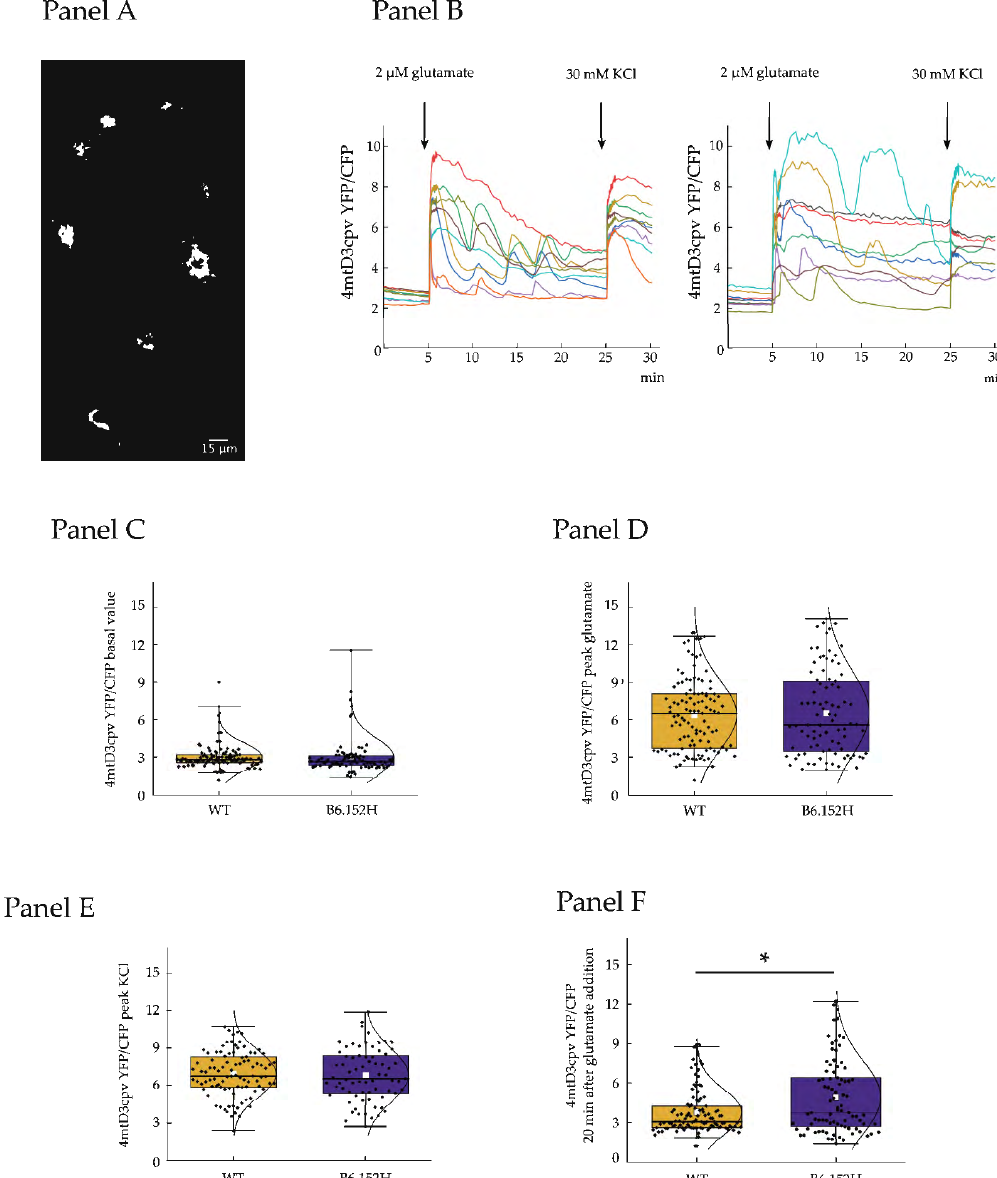
Figure 8. Mitochondrial Ca 2+ transients in hippocampal primary cultures induced by glutamate. Panel ( A ), representative image of 14 div hippocampal neurons expressing mitochondria-targeted cameleon probe 4mtD3cpv. Panel ( B ), representative traces of mitochondrial Ca 2+ uptake in hippocampal neurons expressing 4mtD3cpv, left WT; right B6.152H cells. Where indicated the cells were challenged with 2 µ M glutamate and 30 mM KCl addition. Panels ( C – E ), quantifications of 4mtD3cpv ratio fluorescence for, respectively: C basal values (WT n = 111 cells, median = 2.83; B6.152H n = 89 cells, median = 2.66, Mann–Whitney probability test, exact prob. = 0.063: at the 0.05 level, the two distributions are not significantly different); ( D ), peak glutamate (WT n = 111 cells, median = 6.5; B6.152H n = 89 cells, median = 5.6, Mann–Whitney probability test, exact prob. = 0.858: at the 0.05 level, the two distributions are not significantly different); ( E ) peak KCl (WT n = 95 cells, median = 6.76; B6.152H n = 71 cells, median = 6.54, Mann–Whitney probability test, exact prob. = 0.65: at the 0.05 level, the distributions are not significantly different). Panel ( F ), quantification of the 4mtD3cpv fluorescence ratio measured 20 min after the addition of 2 µ M glutamate (WT n = 111, median = 3.07; B6.152H n = 85 median = 3.79, Mann–Whitney probability test, exact prob. = 0.029: at the 0.05 level, the distributions are significantly different). Box plot: Box height, 25–75%; whiskers, 1–99%; white square, mean; transverse line median; curve, normal distribution equation. The spontaneous movements of mitochondria during the acquisition were controlled for in off-line analysis to ensure the evaluated organelles rested within the boundary of the outlined roi. * p ≤